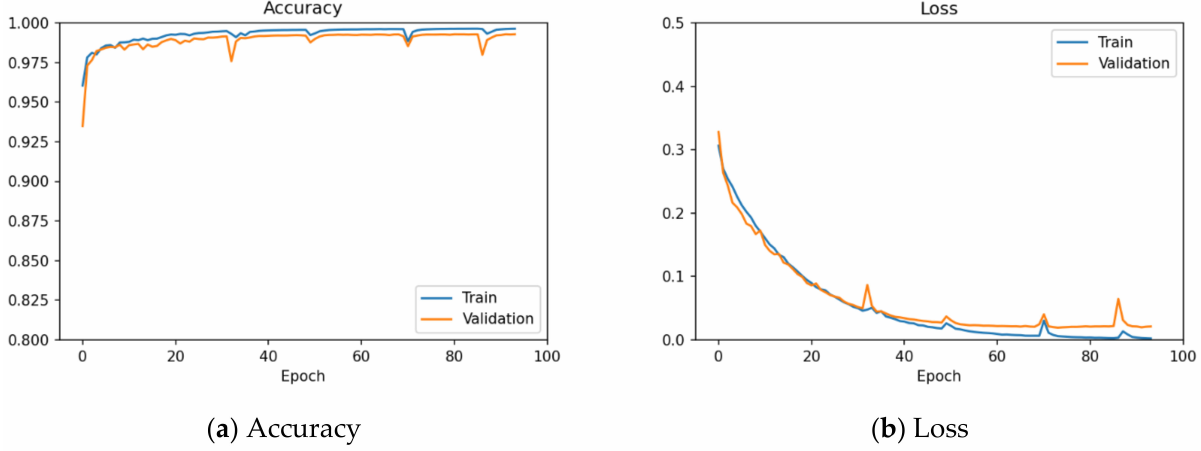
Figure 5. Training process of the U-Net network.